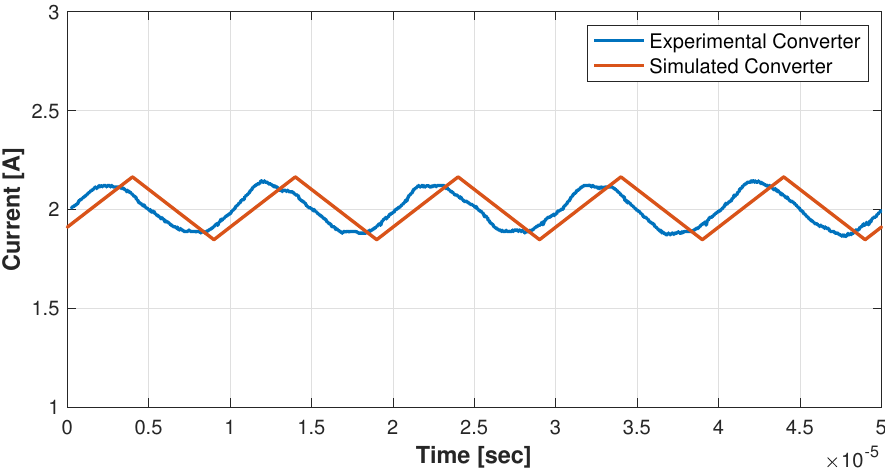
Figure 32. Acquired data from the oscilloscope plotted in the MATLAB